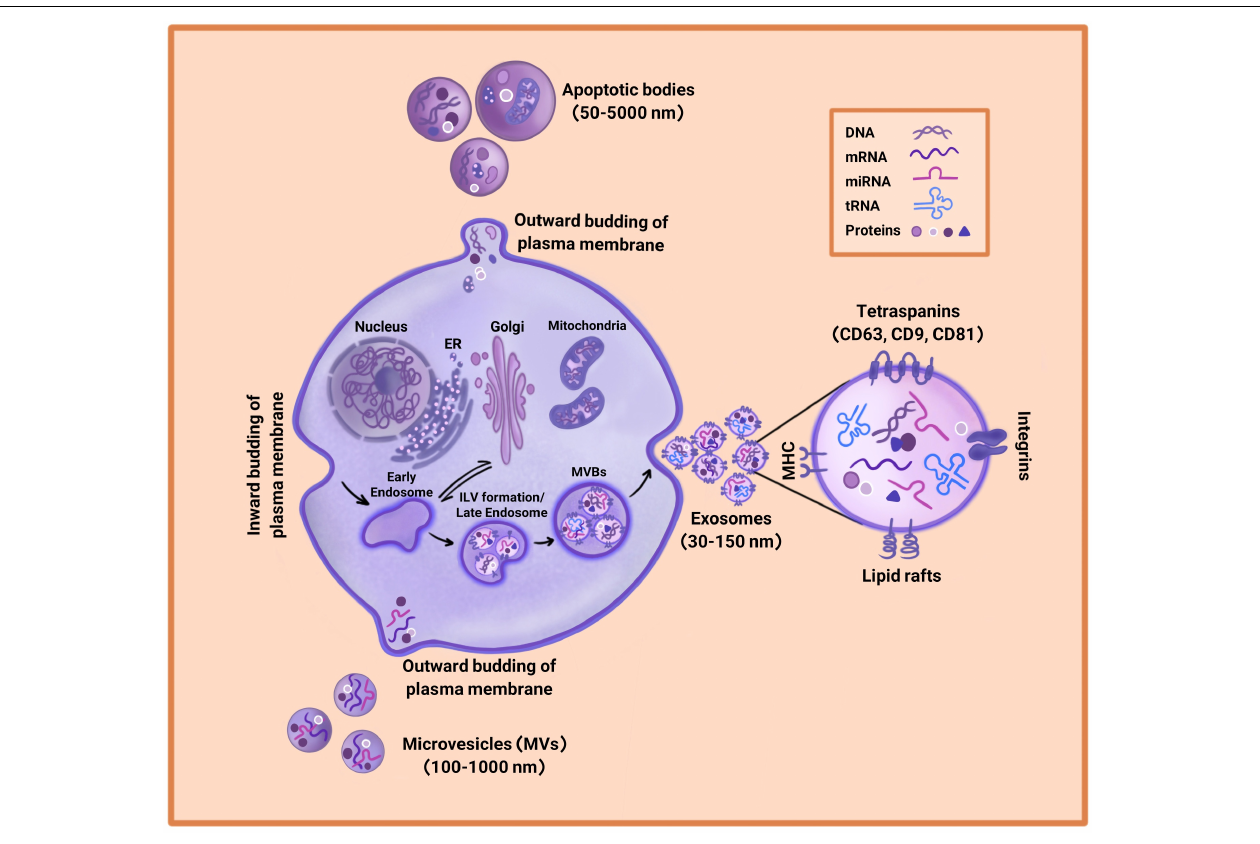
FIGURE 1 | Extracellular Vesicles (EVs) biogenesis. EVs consist of exosomes, microvesicles, and apoptotic bodies. Exosomes arise through the inward budding of plasma membrane and are the smallest in diameter (30–150 nm). Microvesicles are larger in diameter (100–1,000 nm) and are driven through an outward budding of the plasma membrane. Apoptotic bodies range from 50 to 5,000 nm in diameter and are generated by outward budding of the plasma membrane from dying cells. Due to different biogenesis mechanisms, the compositions of exosomes, microvesicles, and apoptotic bodies are